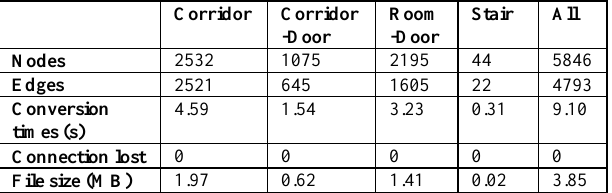
Table 3. The statistics of information in IndoorGML conversion